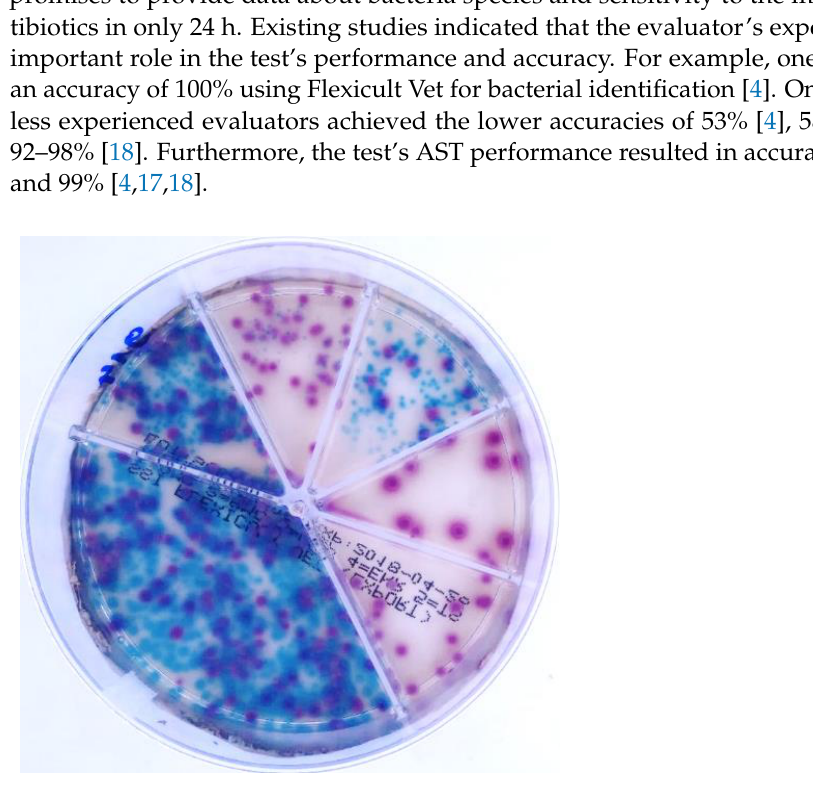
Figure 1. Escherichia coli (red colonies) and Enterococcus faecalis (turquoise) on Flexicult Vet agar.